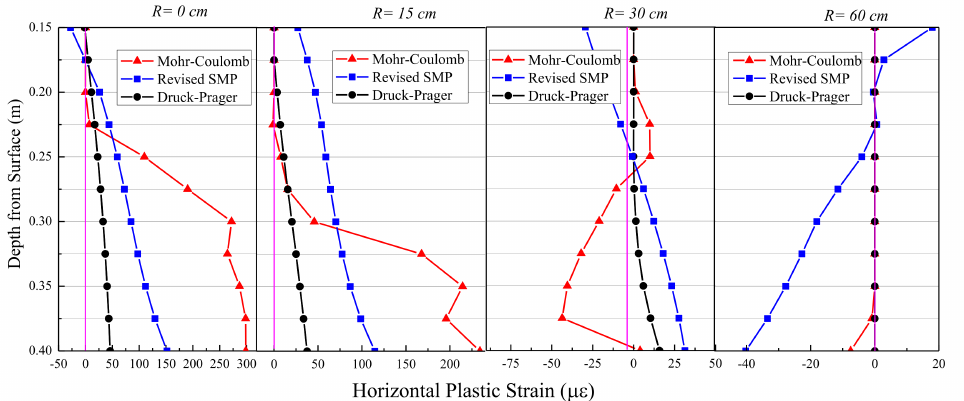
Figure 5. Horizontal plastic strain of an UGM layer using the three